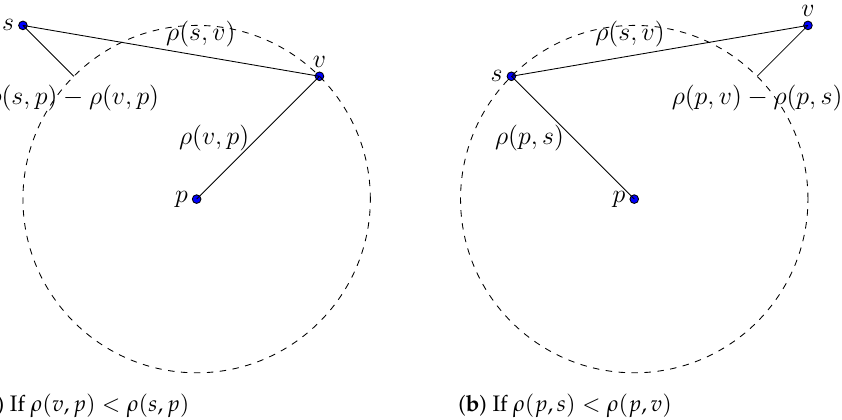
Figure 1. Geometrical illustration of the inequality of Lemma 1 for simplicity on the standard Euclidean